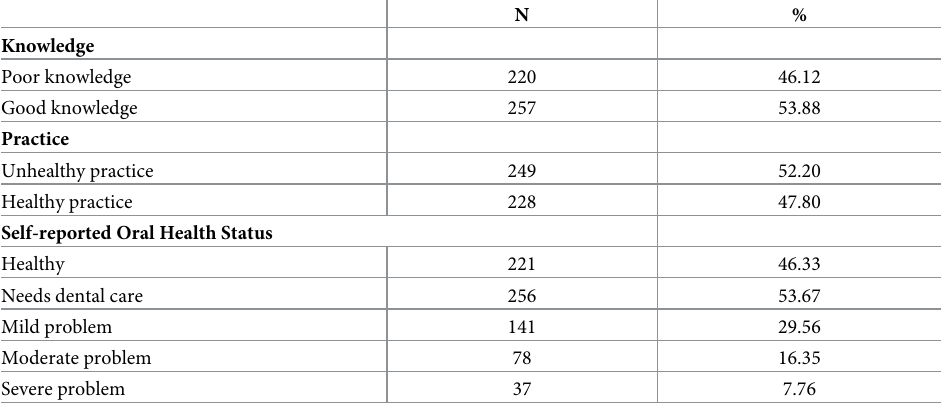
Table 3. Prevalence of oral health knowledge, practice, and self-reported oral health status (n = 477).